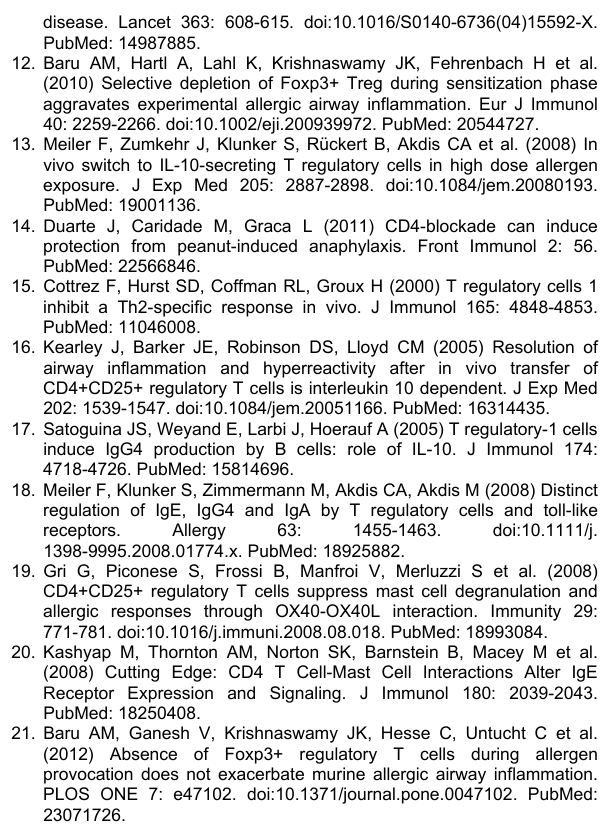
Figure S1. Efficacy of Treg depletion by DT injection in DEREG mice. DEREG mice were injected with DT (or PBS as control) one day before IgE anti-DNP mAb injection, and the frequency of Foxp3 + Treg was assessed 2 days later by FACS analysis using anti-CD4-PercP-Cy5.5 and anti-CD25-PE conjugates and Foxp3 was determined by GFP expression. The dot plots show the percentage of CD25 + /Foxp3 + cells in gated CD4 + T